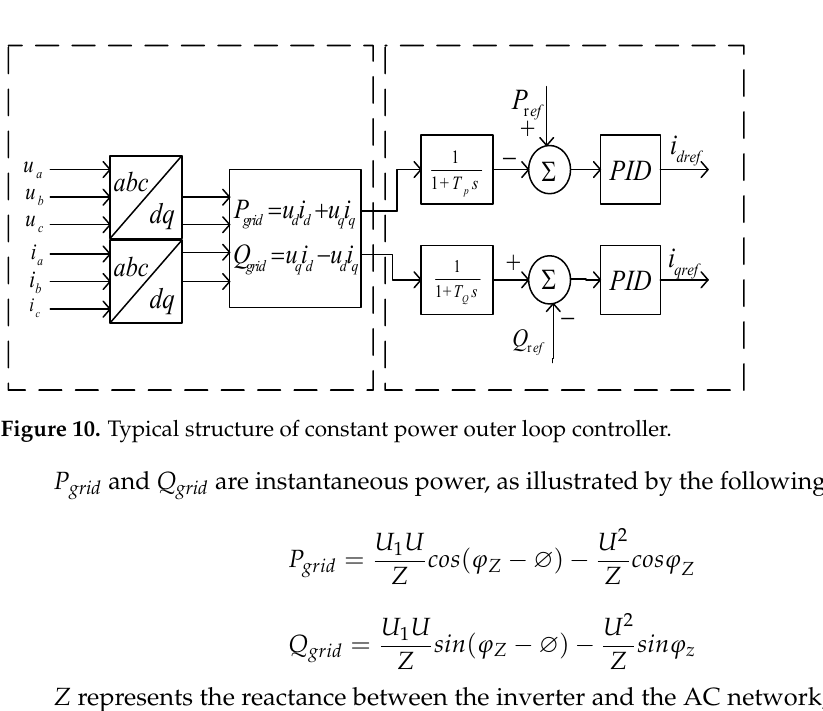
10 of 16 Figure 9. Boost chopper double closed-loop control system structure. The three-phase voltage inverter adopts a double closed-loop structure to design a constant power (PQ) control scheme, and its control goal is to make the active and reactive power output by the DC/AC inverter meet the expected goals at the same time. That is, when the voltage and frequency of the AC network change within the specified range, the active and reactive power output by the inverter remain unchanged. When the voltage and frequency of the connected power grid change within the pre- determined range, constant power regulation maintains the output power of the distrib- uted power supply at the reference value. Decoupling active power from reactive power is accomplished through constant power regulation. The distributed power system’s ini- tial operational state has a frequency of f 0 and a voltage of U 0 at the connecting bus. In this instance, the reference values for the active power and reactive power, P ref and Q ref , are the output active power and reactive power, respectively. Both the reactive power con- troller and the active power controller can modify their characteristic curves for voltage and frequency changes [41]. When the frequency and voltage vary within a reasonable range, i.e., f min ≤ f ≤ f max , U min ≤ U ≤ U max , the active power and reactive power, or the reference value P ref and Q ref , remain constant. The voltage and frequency cannot be kept in a stable state using this control strategy. As a result, a stable control voltage and frequency controller are required for operation on an isolated island [42]. To obtain the dq axis components (i dq and u dq ) and the instantaneous power P grid and Q grid , first take the three-phase instantaneous current i abc and instantaneous voltage u abc , then park transform them. To acquire the average power P filt and Q filt , the obtained instan-